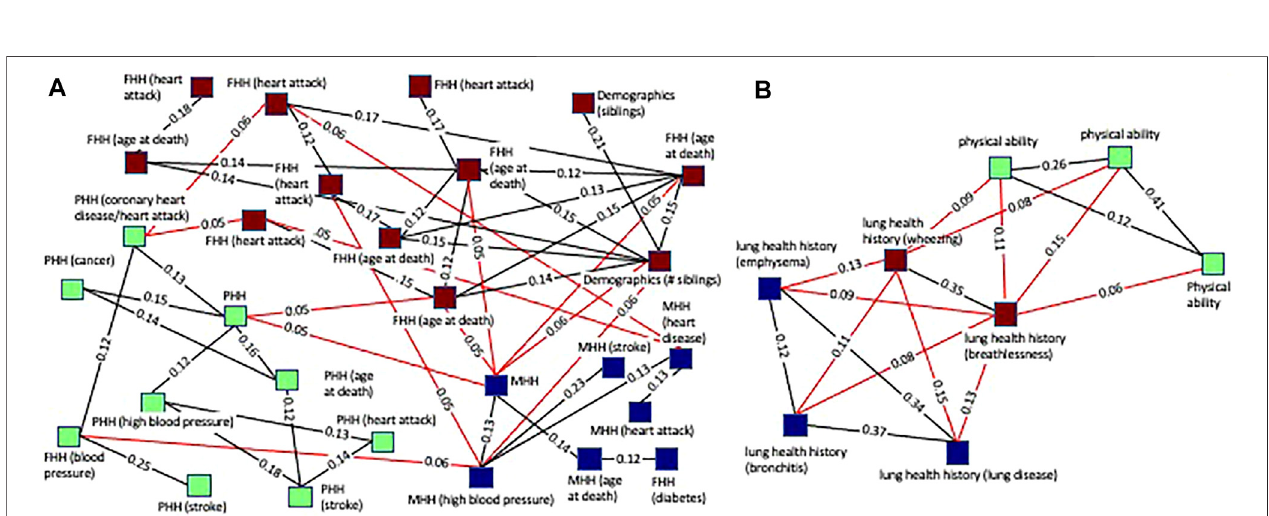
FIGURE 5 | Plots of multiple cluster groups demonstrating interconnectivity between cluster groups. Each node is a variable cluster with cluster groups being identi fi edbynodecolor.Blacklinesareintra-clusteredgesandredlinesareinter-clusteredges.Thethresholdforintra-clusteredgesis0.12andforinter-clusteredgesis 0.05. (A) Threeinterconnectedclustergroupsrelatedtohealthhistory.Thegreen(paternalhealthhistory-PHH)andblue(maternalhealthhistory-MHH)clustersarelinked throughtheredclusters(familyhealthhistory-FHH). (B) Threeinterconnectedclustergroups.Thegreen(physicalactivity)andblue(historyoflungdiseases),cluster groups are linked through the red cluster group (history of wheezing and breathlessness) but not directly connected to each other.